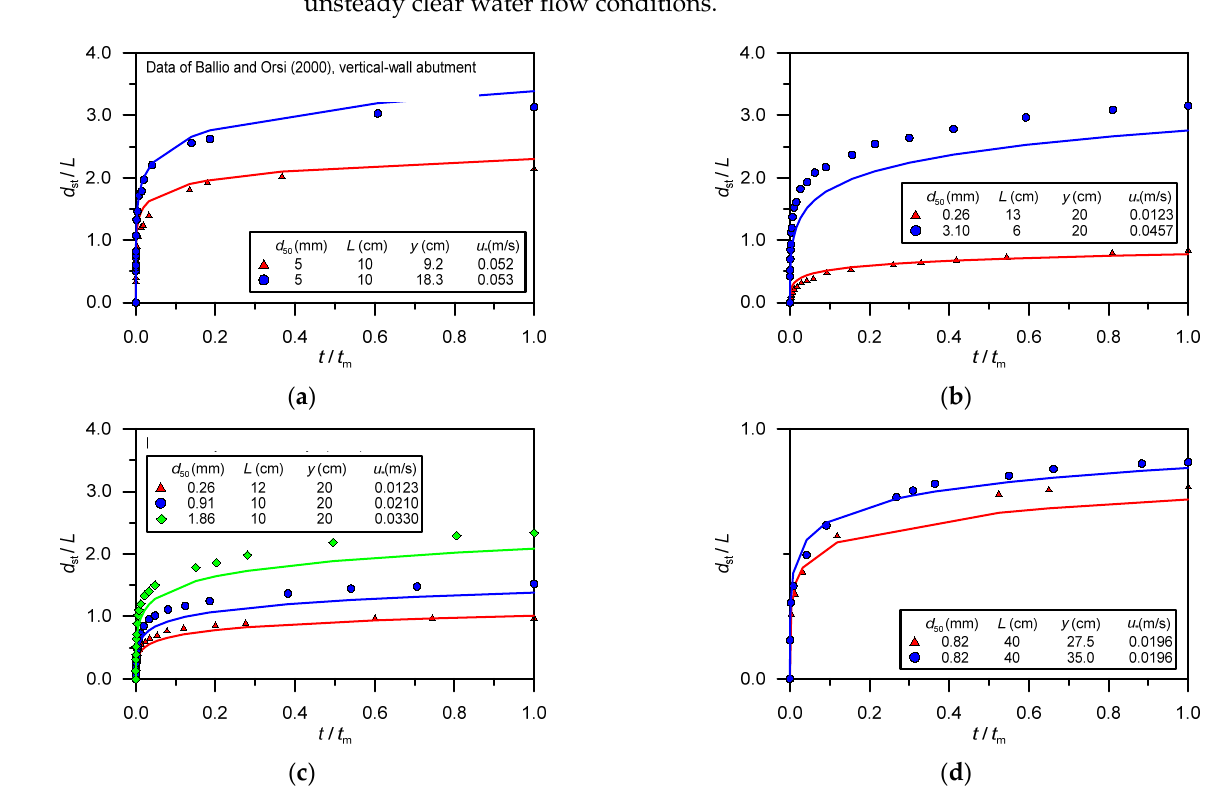
Figure 8. Comparison of scour evolution between the proposed model and the experimental data of: ( a ) Ballio and Oris [16] at a vertical wall abutment, ( b ) Dey and Barbhuiya [19] at a semi-circular abutment, ( c ) Dey and Barbhuiya [19] at a 45° wing-wall abutment, ( d ) Tey [14] at a 45° wing-wall abutment.